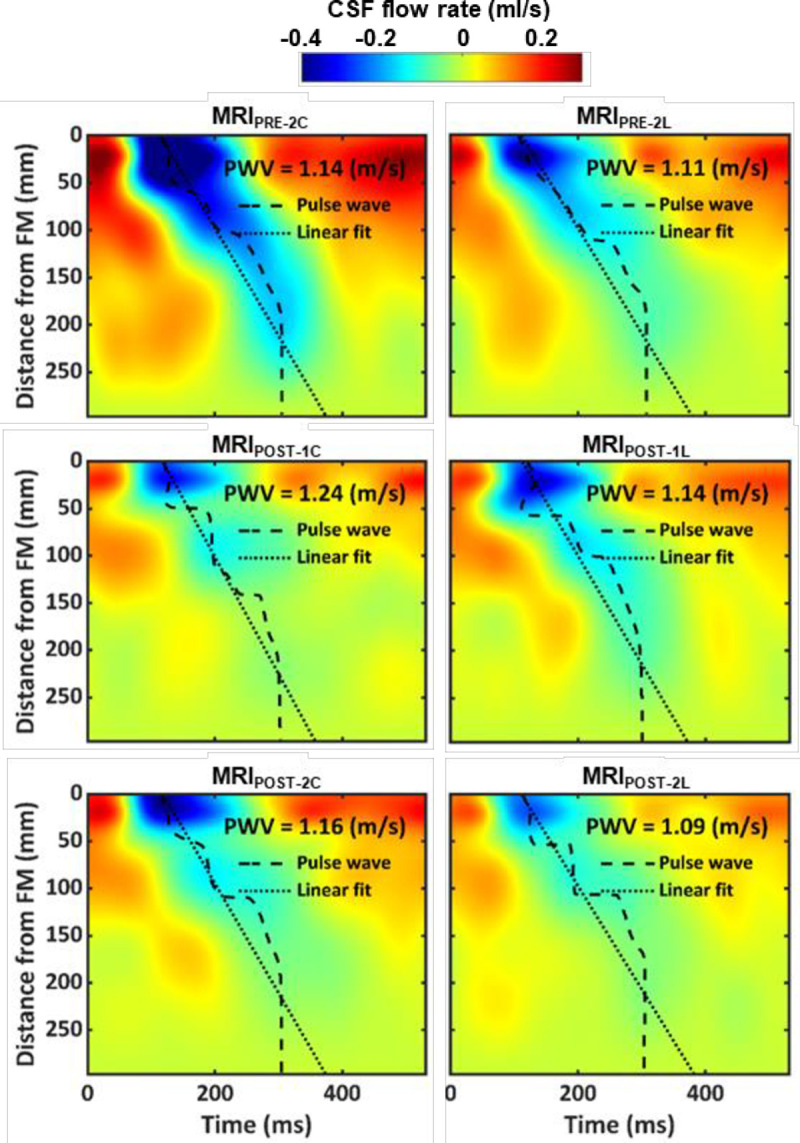
Mean CSF flow waveforms and Spatial-temporal distribution of CSF flow rate.Spatial-temporal distribution of the interpolated CSF flow rate along the spine for all cases measured by PC-MRI. Dashed line indicates peak CSF flow rate at each axial level and dotted line indicates linear fit on top of those values used to compute CSF pulse wave velocity (PWV).